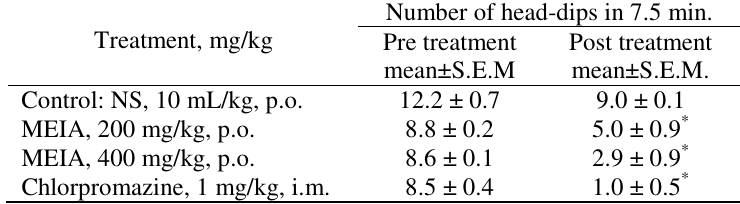
Table 2. Effect of MEIA on exploratory behavior in mice Number of head-dips in 7.5